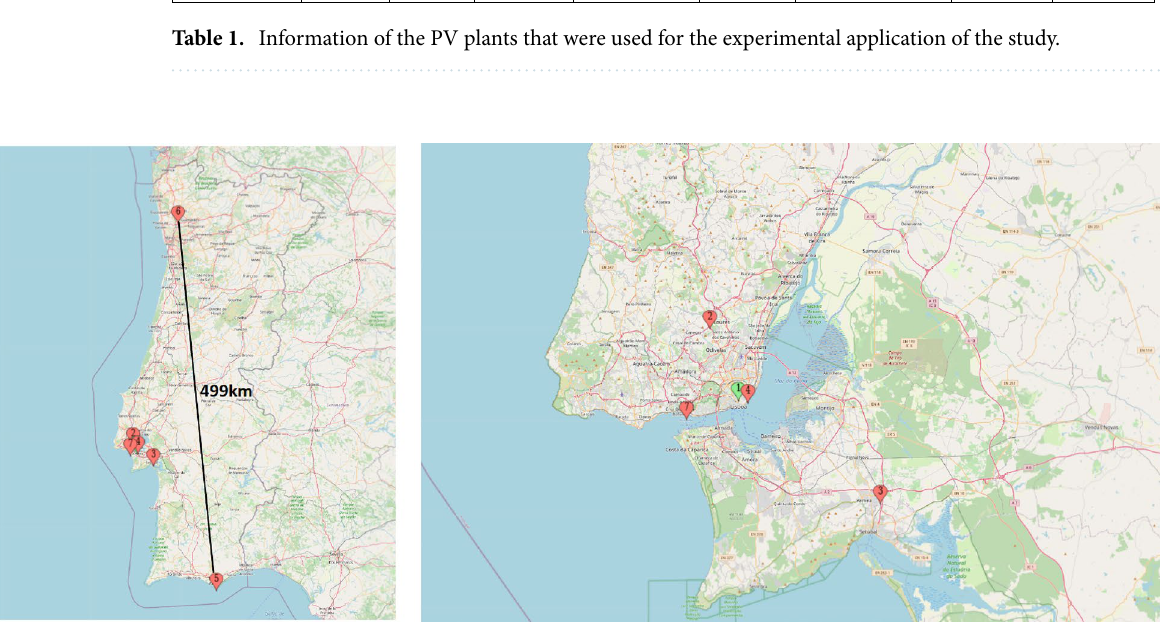
Figure 1. A map depicting the locations of the inspected PV plants. The 7 PV plants are located in four different Portuguese cities (Lisbon, Setubal, Faro, Braga) allowing for assessment of model performance regardless of the city. The image on the right offers a focus on the city of Lisbon where 4 PV plants are located (map created with https:// www. mapcu stomi zer. com/, OpenStreetMap